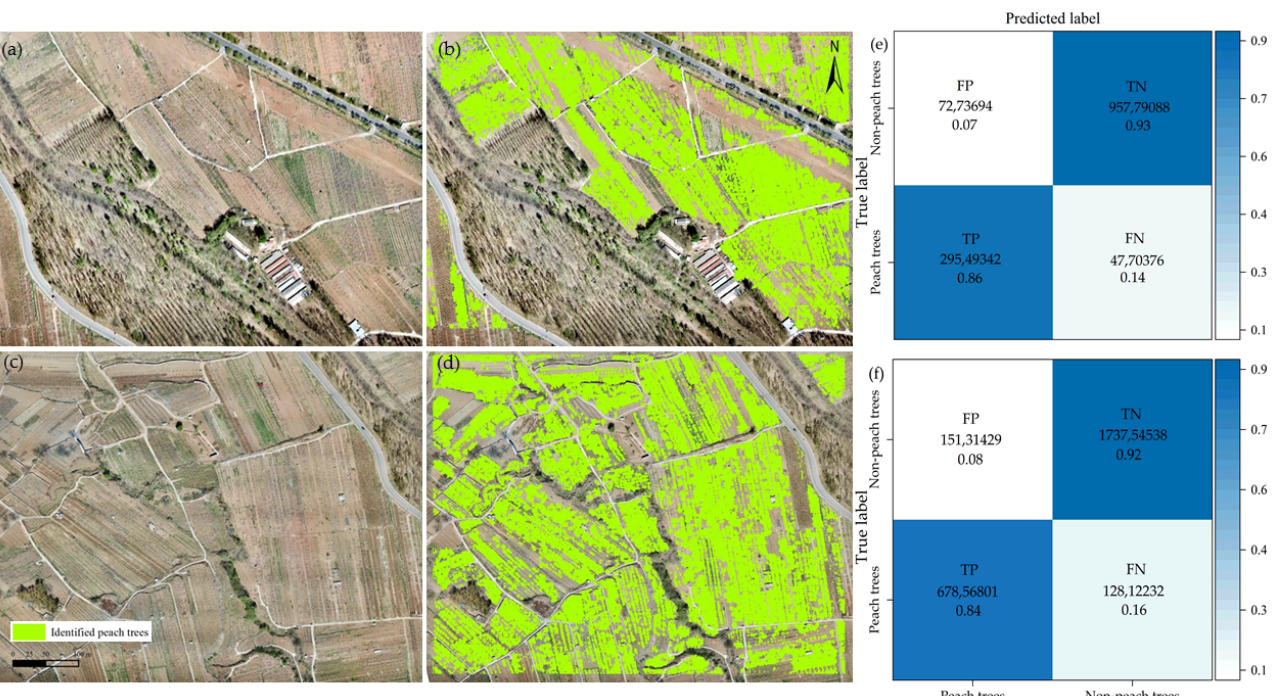
Figure 5. The spatial distribution of projected peach trees in cultivated land. Images show the ground truth for peach trees in ( a ) G2 and ( c ) G3 and the prediction results of the U-net algorithm identification for ( b ) G2 and ( d ) G3. The graphs show the results of the U-net algorithm: ( e ) G2 confusion matrix and ( f ) G3 confusion matrix. The pixel values describe the performance of the classification model for each data set. The matrix rows represent the true value, and the columns represent the predicted value. The decimal represents the proportion of the pixel values for the four types.